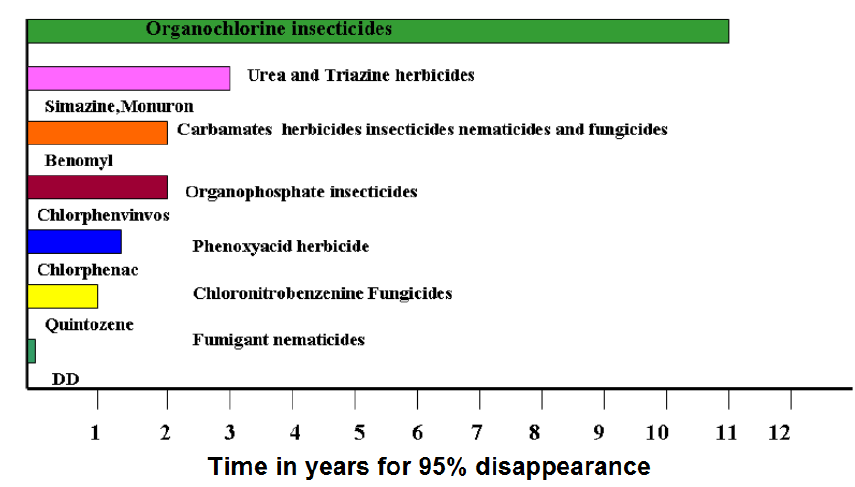
Figure 8. Pesticide disappearance (95%) from soil (time in